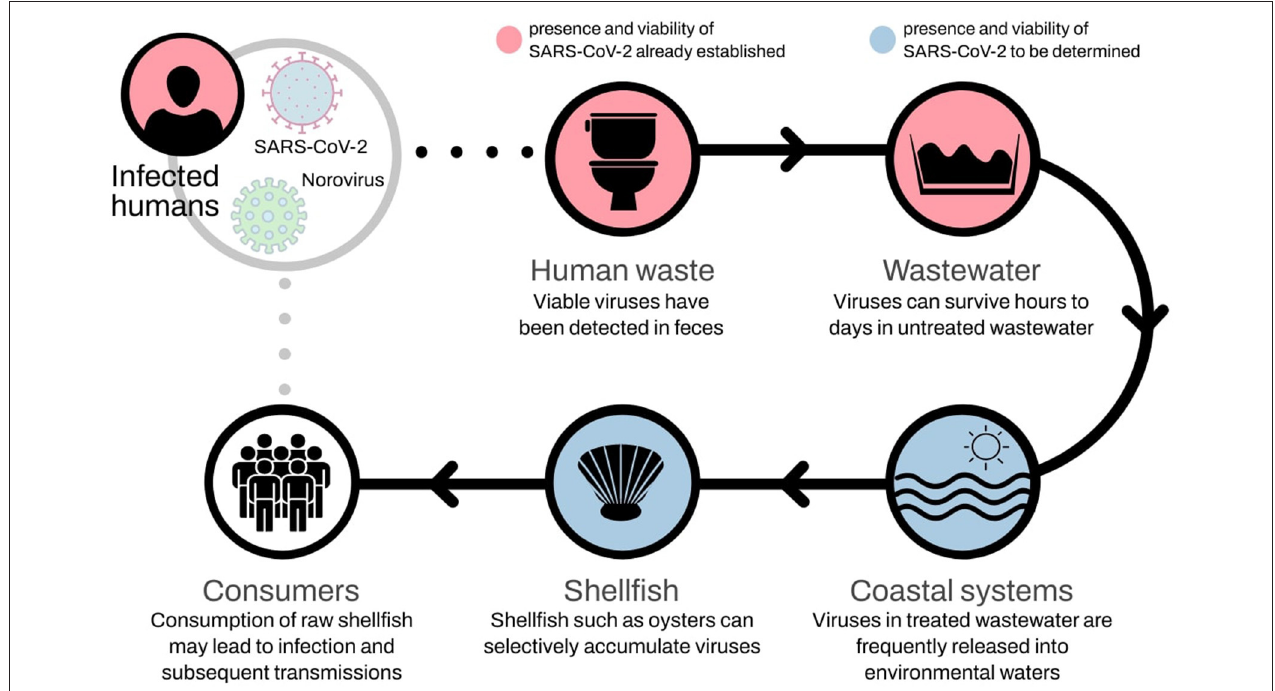
FIGURE 1 | Potential foodborne transmission of SARS-CoV-2 via shellfish. Such transmission route is known to occur with